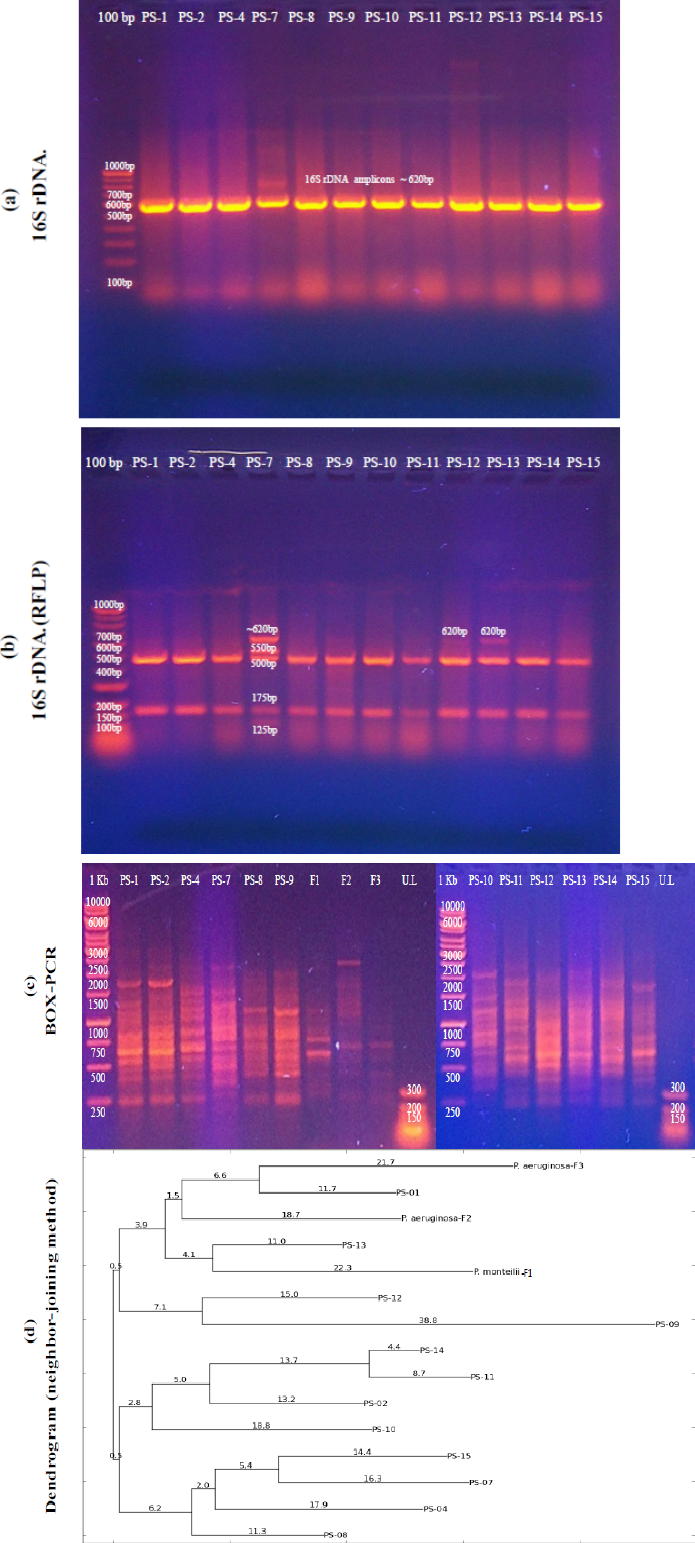
Fig. 1: Molecular basis of identification of Pseudomonas spp. (a) PCR amplification of 16S rDNA, (b) RFLP analysis of 16S rDNA gene PCR products obtained by the restriction enzyme Hae III , (c) BOX PCR analysis for establishing intra-species variation and (d) phylogenetic tree constructed using the neighbor-joining method by PyElph1.4 software. The reaction products were analyzed on 1.5% (a and c) and 2% (b) agarose gels and visualized by staining in ethidium bromide. F1 and F2-F3 are the indigenous control strains of P. monteilii and P. aeruginosa, respectively, while PS numbers represent Pseudomonas isolates in this study. 1 Kb, 100 bp and, UL, ultra-low range DNA ladders